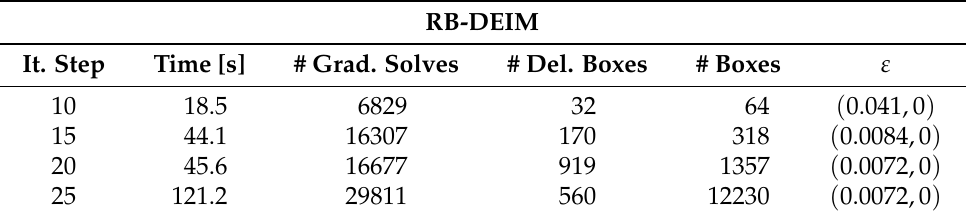
Table 4. Modified subdivision algorithm with the steepest descent method.